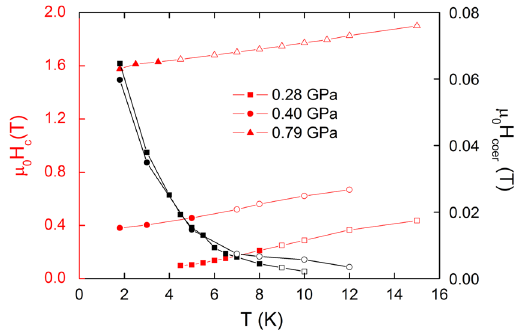
Fig. 6 Temperature dependence of critical magnetic fi eld μ 0 H c of the metamagnetic transition and coercive fi eld μ 0 H coer of ferromag- netic portion of the curve for selected pressures for the UCo 0.990 R- u 0.010 Al sample for fi eld applied along the c -axis, full symbols indicate the fi elds where fi rst order transition is observed, open symbols indicate the presence of second order transition